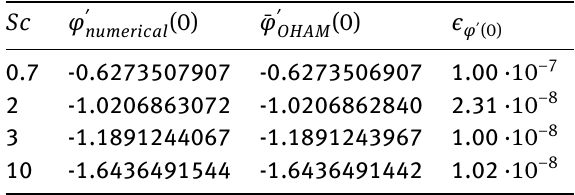
Figure 2: Variation of the stream function ¯ f ( η ) with increasing of the suction/blowing parameter S for λ = 0.1 :